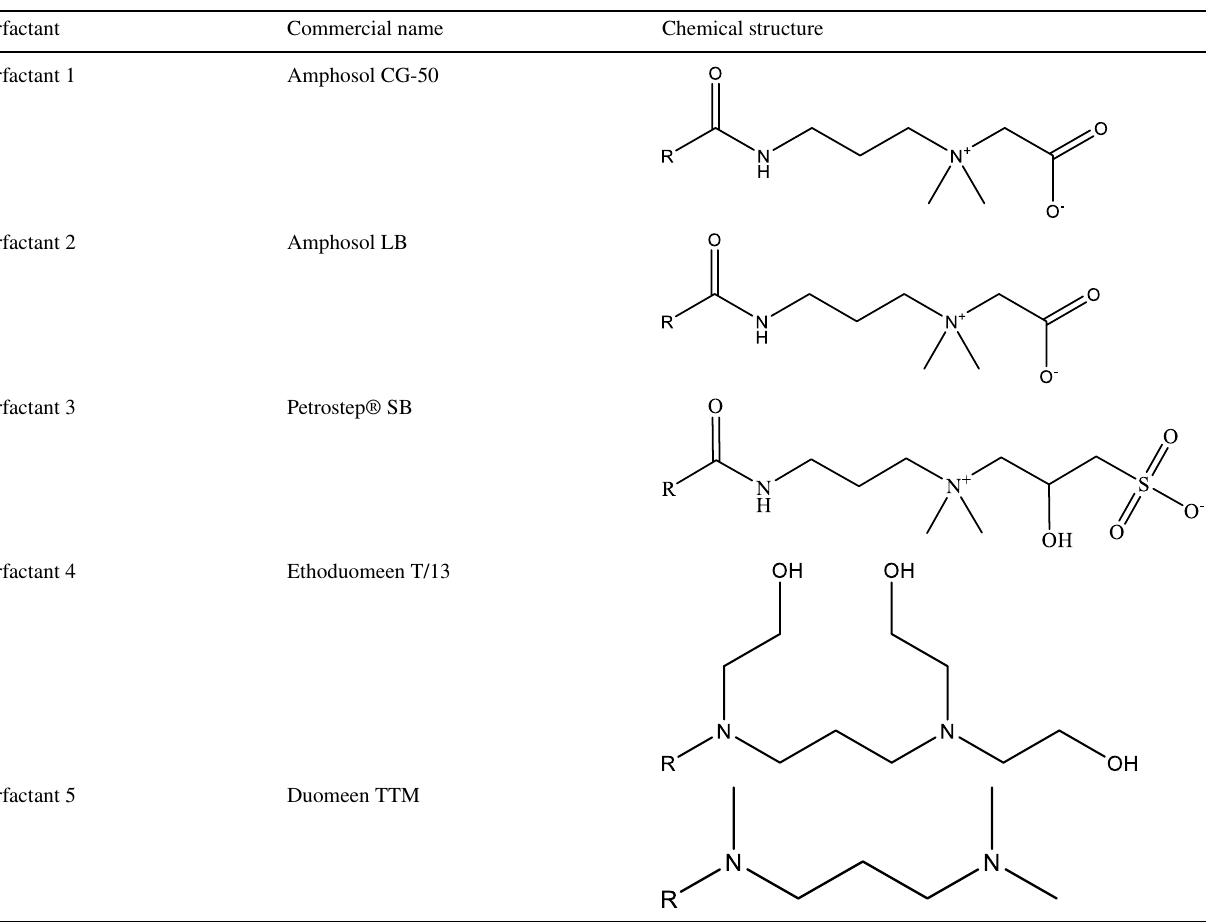
Table 1 List of surfactants with depicted chemical structures used in this study